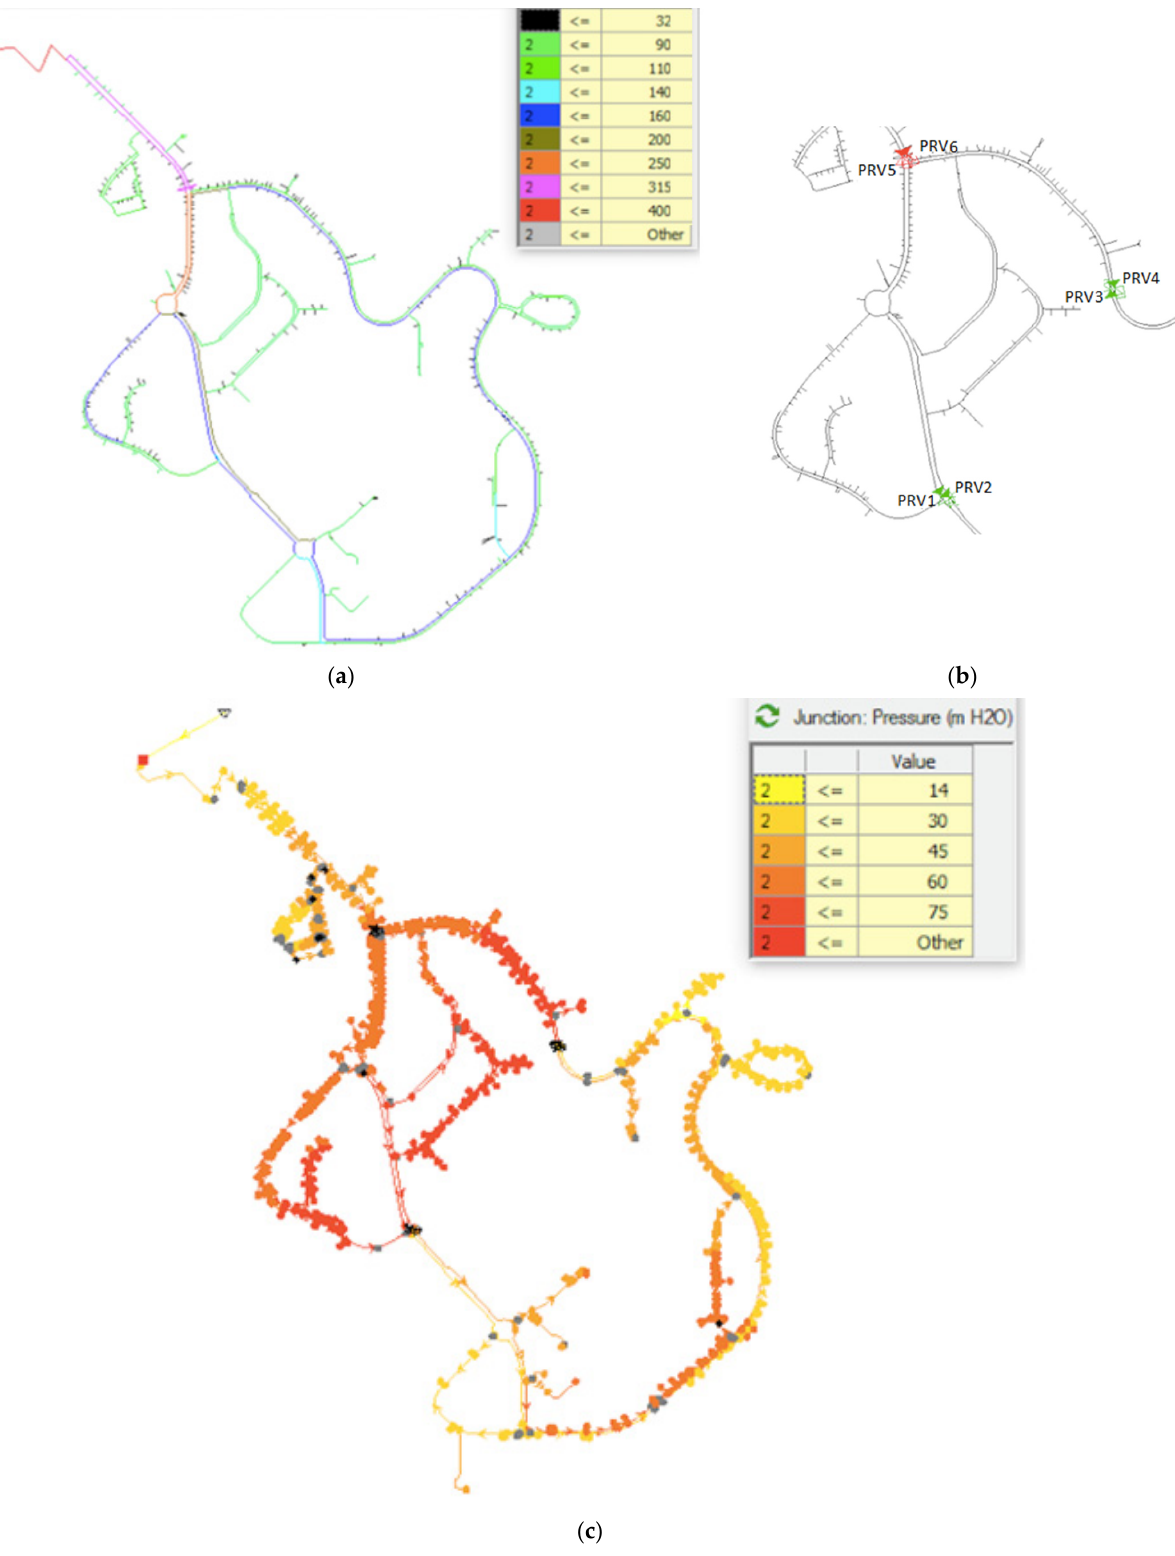
Figure 10. Diameter range of the water network under study ( a ); Localization of PRVs ( b ); pressure distribution in the WDN of Beloura ( c ).